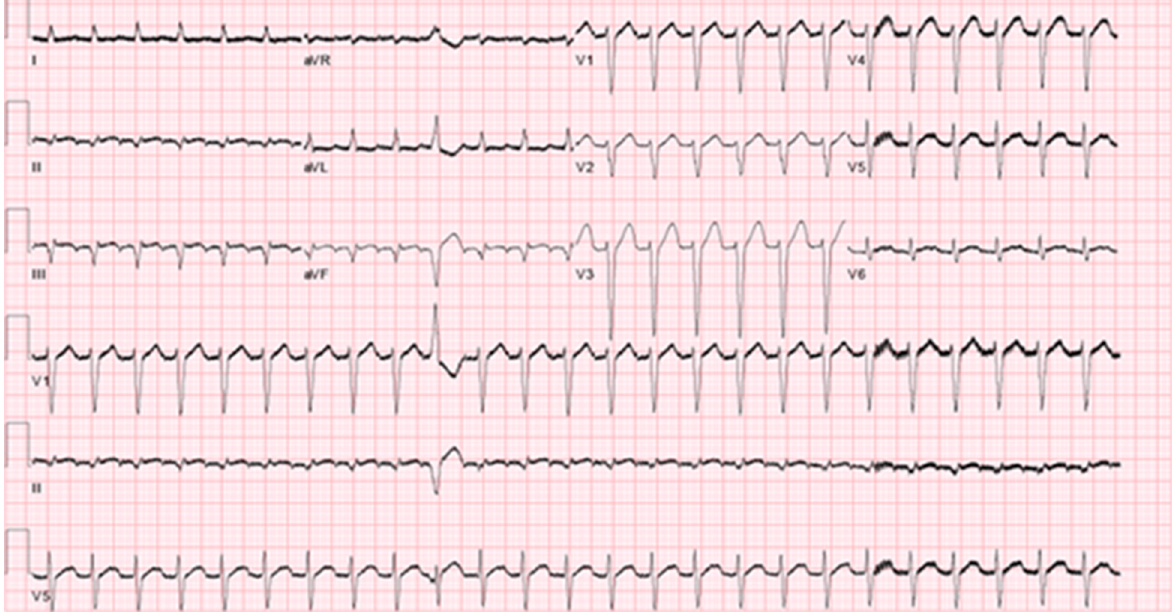
Figure 1. Electrocardiogram two hours later after the first ECG showing long RP supraventricular tachycardia with premature ventricular complexes delineating the p waves. However, cannot rule out atrial flutter with 2 to 1 block. Differential diagnosis includes atypical fast-slow AVNRT, orthodromic AVRT and atrial tachycardia. Q waves are also noted in leads II, III, AVF suggestive of old inferior myocardial infarction.